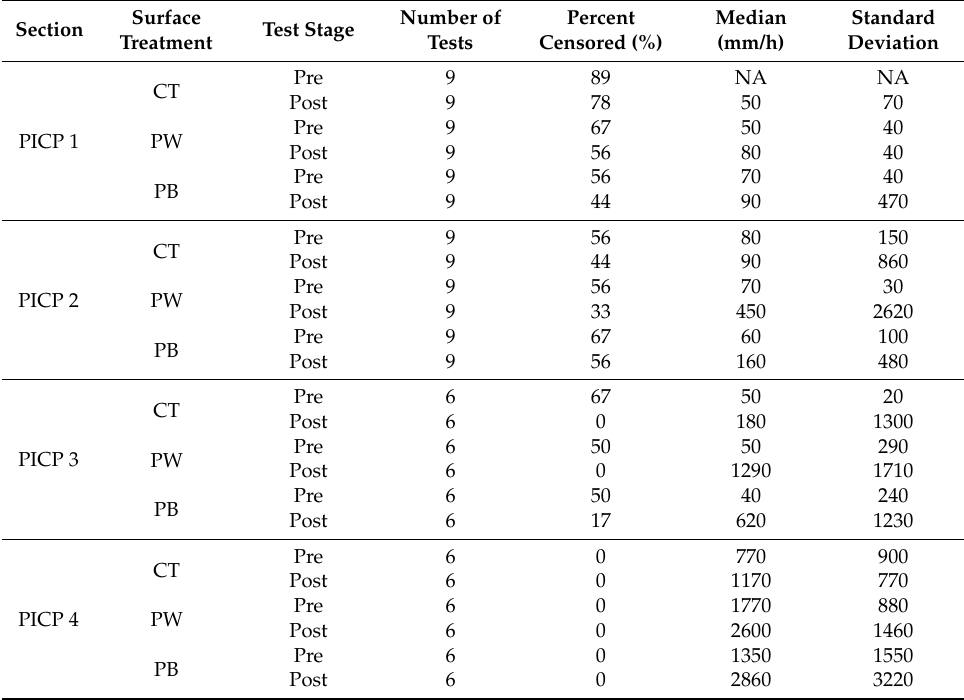
Table 4. Descriptive Statistics for each site by surface treatment.